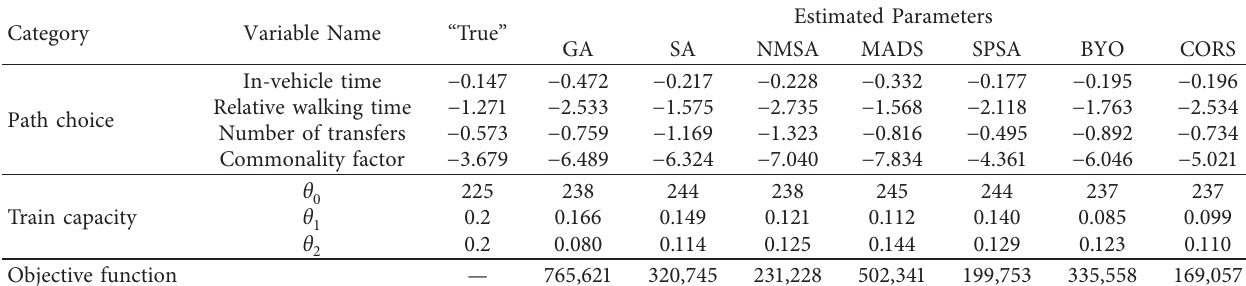
Table 8: Estimation results of the crowding-sensitive train capacity